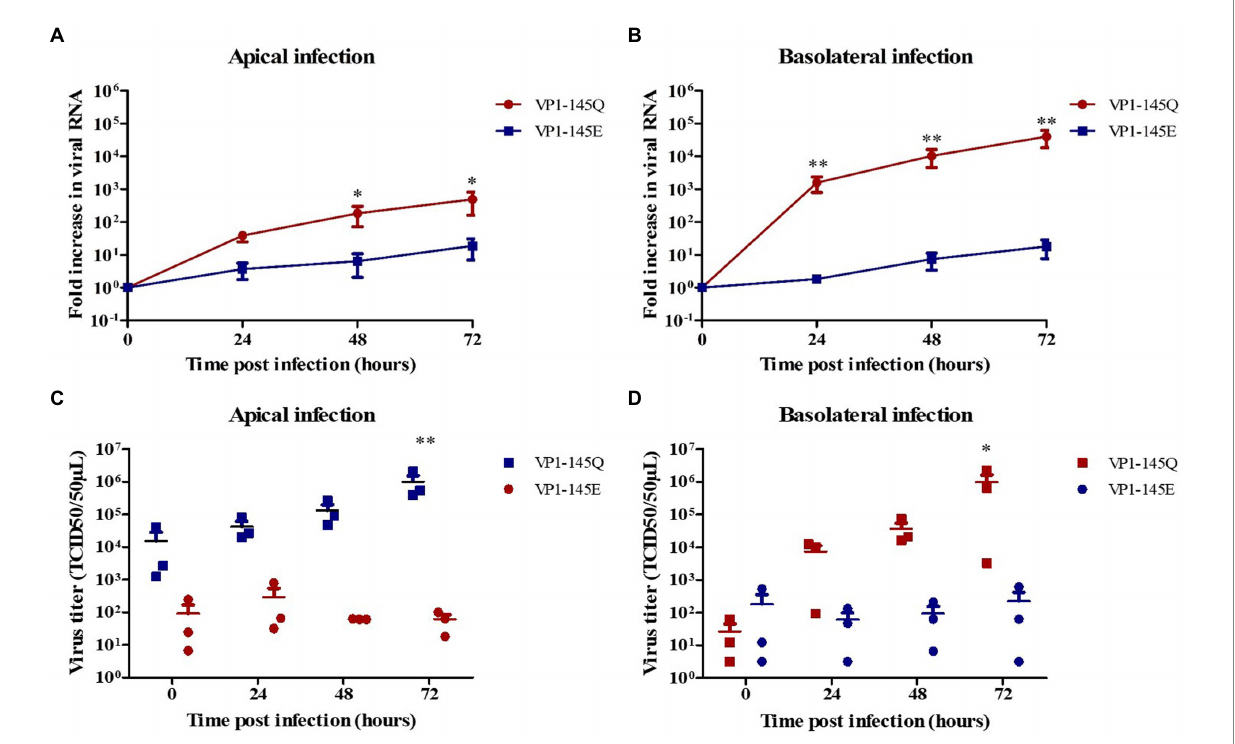
FIGURE 2 Replication kinetics of EV-A71 mutants VP1-145Q and VP1-145E in fetal intestinal organoid-derived monolayers. Fold increase in viral RNA copies and virus titers in the media collected at different time points from the apical surface after apical (A,C) and basolateral (B,D) inoculation, respectively. In all cases, data represent the geometric mean ± SEM of four biological replicates with two technical replications per biological replicate. * value of p < 0.05; ** value of p